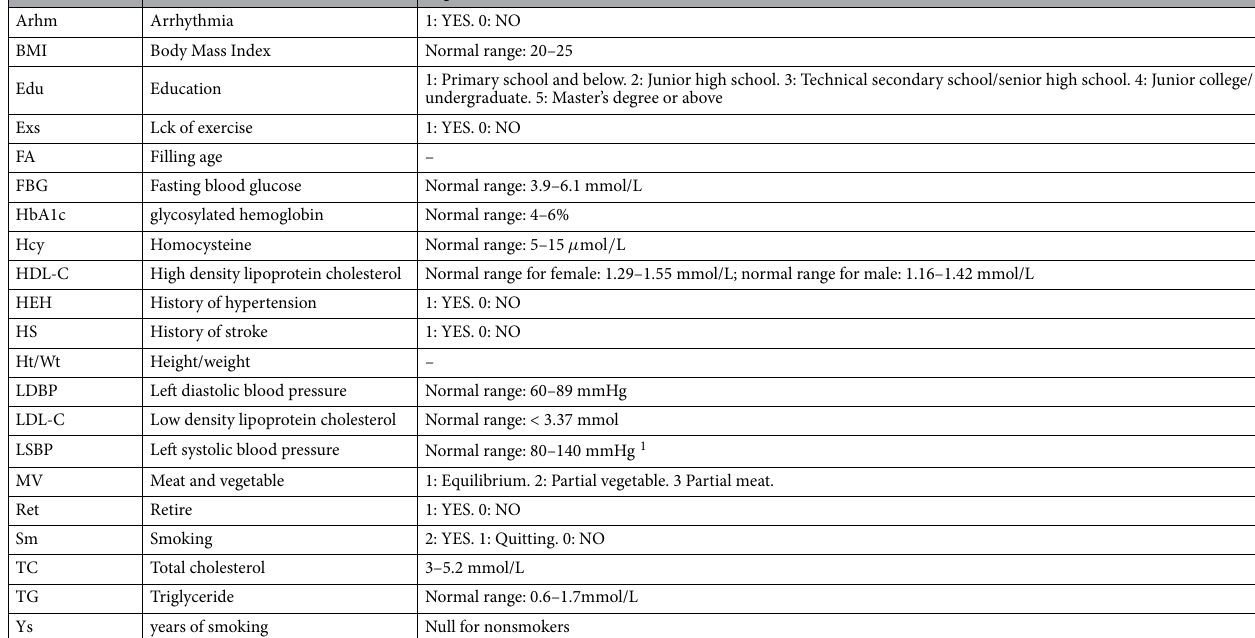
Table 1. Explanation of Selected Features. 1 The normal range of LSBP is 80–140 mmHg and the optimal range is 80–120